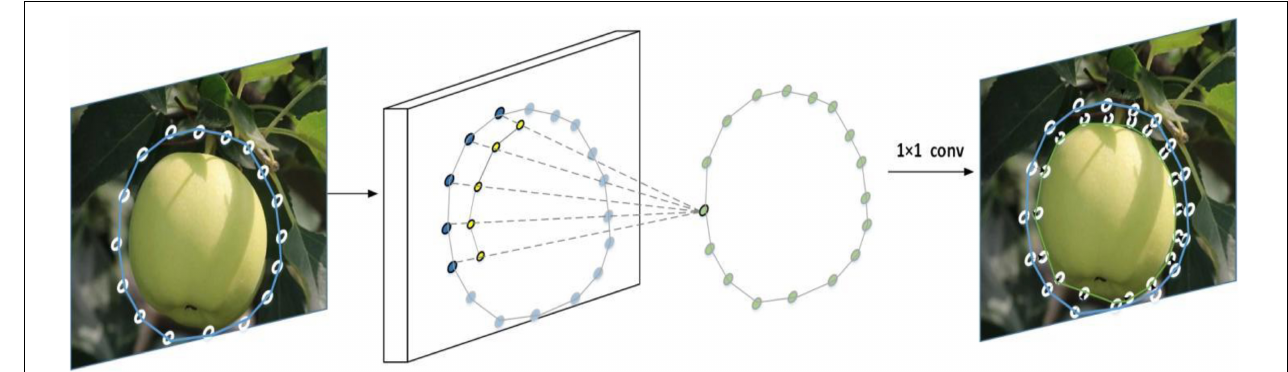
FIGURE 5 | Fine-tuning of the profile of the apple